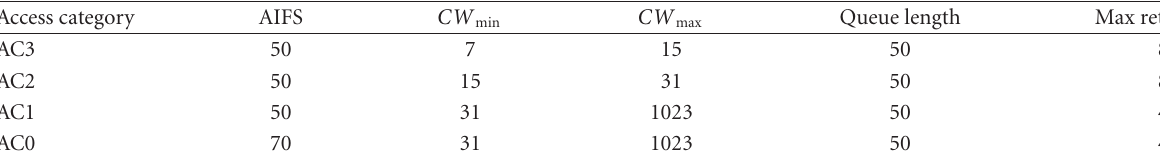
Table 1: 802.11e MAC parameters.